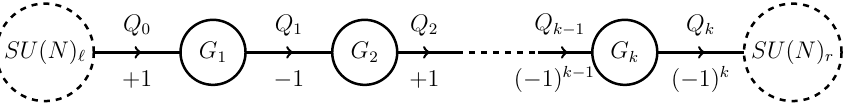
Figure 1 . The moose diagram for the qdms-confining SU( N ) k model [5], showing the k gauge groups G i = SU( N ) i and the global SU( N ) ‘ × SU( N ) r symmetry. Each Q j transforms as a bifundamental ( N, N ) under the adjacent G j × G j +1 . The quark charges under the global U(1) B symmetry are indicated in the lower row. Arrows pointing into (out of) a group G j indicate that a quark transforms in the (anti)fundamental representation of that